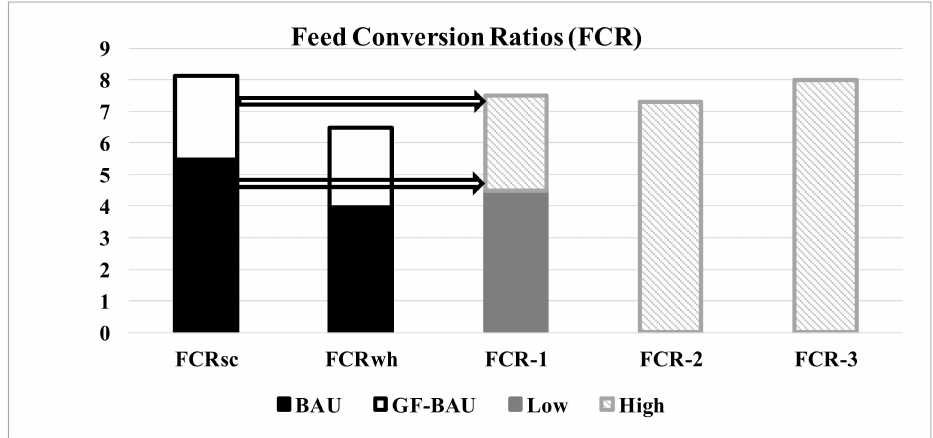
Figure 3. Bar graph of feed conversion ratio (FCR) estimates from Eqs 1 and 2, and from three independent sources: FCR-1 = Byrne (2018), FCR-2 = NRCS-USDA (2009), FCR-3 = Shahbandeh (2020). Table 3. Estimation of feed production, feed conversion ratio (FCR) and beef GHG emissions from crop yields, and 2017 areas and live weights (LW) in Canada. Grain Forage Beef Cattle Feed Beef FCR GHG Scenarios